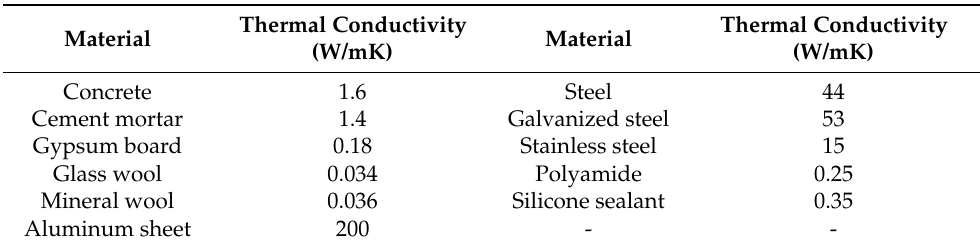
Table 2. Material properties for